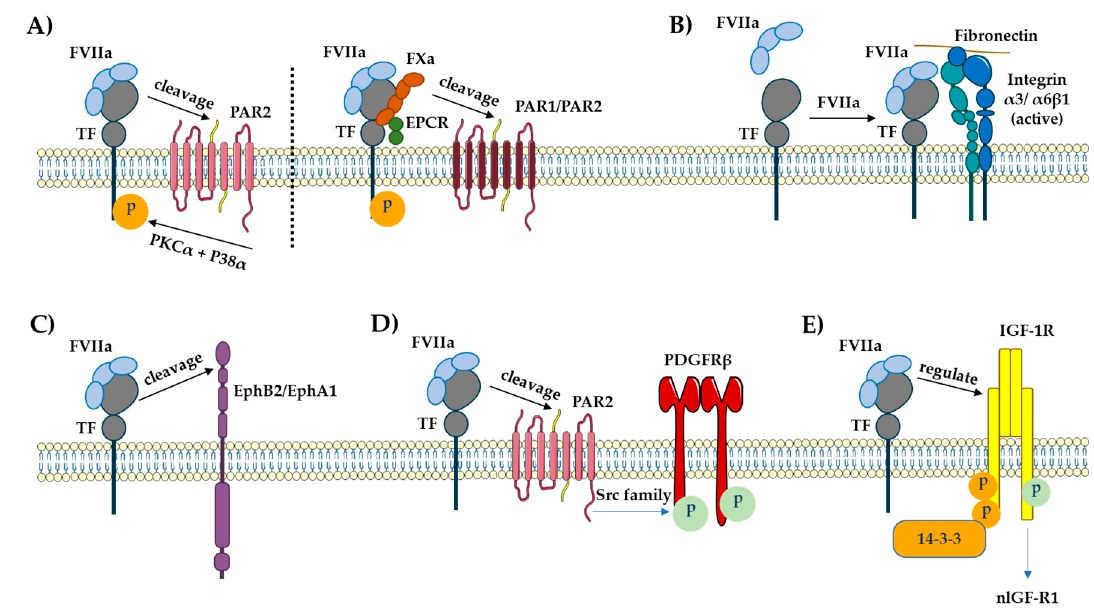
Figure 2. Cell surface-bound full-length TF interacts with a number of different proteins in order to initiate signaling and achieve specificity. ( A ) PAR1 is cleaved by the TF/FVIIa/FXa complex whereas PAR2 is cleaved by both TF/FVIIa and TF/FVIIa/FXa. TF cytoplasmic domain is Ser253 phosphorylated by PKC α and Ser258 phosphorylated by P38 α . ( B ) Association of TF with β 1 integrins is regulated by TF extracellular ligand binding and independent of PAR2 signaling or proteolytic activity of VIIa. ( C ) EphB2 and EphA2 are proteolytic targets of TF/FVIIa. ( D ) TF/FVIIa transactivates the PDGFR β in a PAR2 and Src family. ( E ) TF/FVIIa transactivates IGF-1R and mediates the signaling cascades generated by IGF-1 stimulation. Parts of the figure were drawn using elements from Ser-